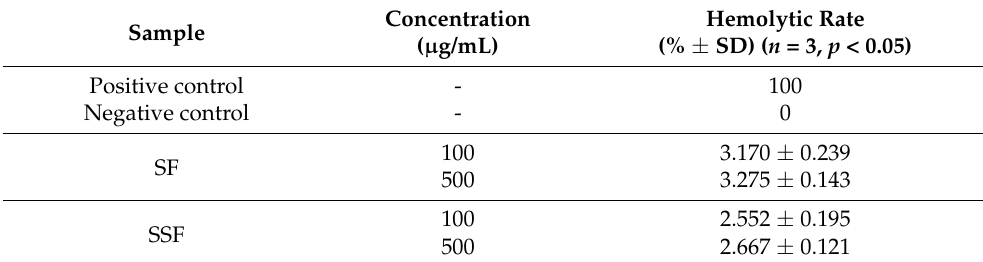
Table 3. Hemolysis percentage of SF and